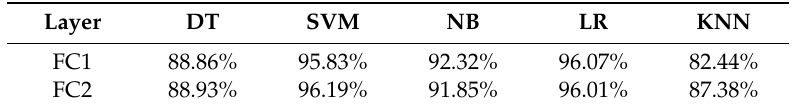
Table 1. Classification accuracy. DT, decision tree; SVM, support vector machine; NB, naïve Bayes; LR, logistic regression; KNN, k -nearest neighbour; FC, fully connected.